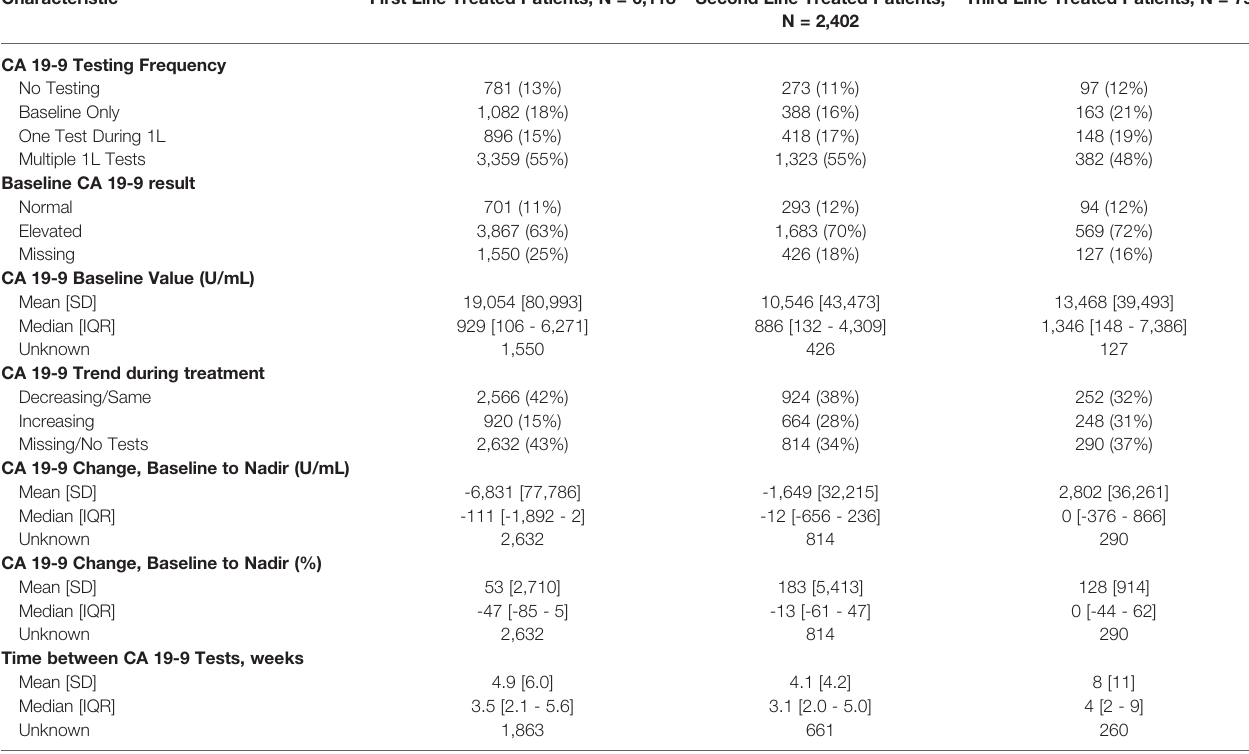
TABLE 2 | CA 19-9 testing patterns and